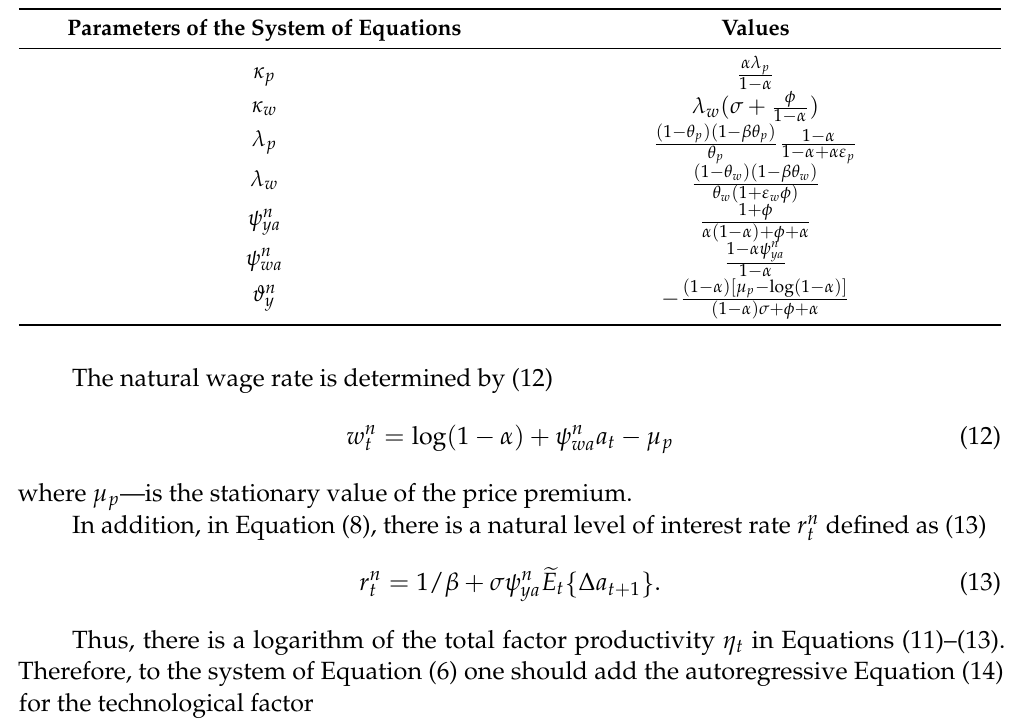
Table 1. Values of the parameters of the system of Equation